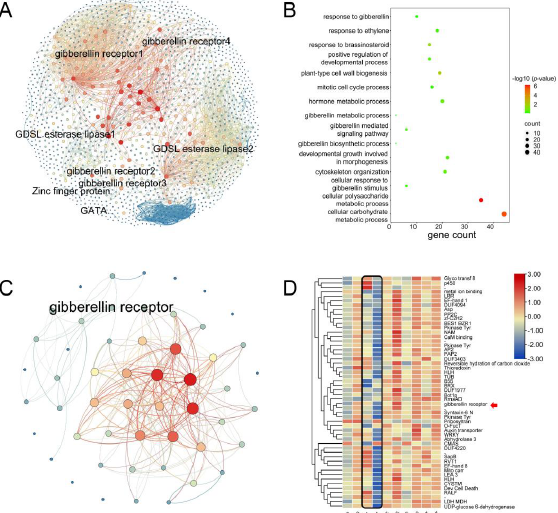
Figure 6. Co-expression network analysis of genes in the bisque4 module. ( A ) Co-expression network of genes in the bisque4 module. The size of nodes represents the number of genes. The width of edges represents the weight between two genes connected; ( B ) GO enrichment analysis of the bisque4 module. The size of the point represents the number of genes. The colors ranging from green to red represent the p -values; ( C ) merging network of hub genes using 12 methods; ( D ) expressions of hub genes from the third week to the seventh week. The color scale ranging from blue to red represents the expression levels of genes. The red arrow indicates the gibberellic receptor.